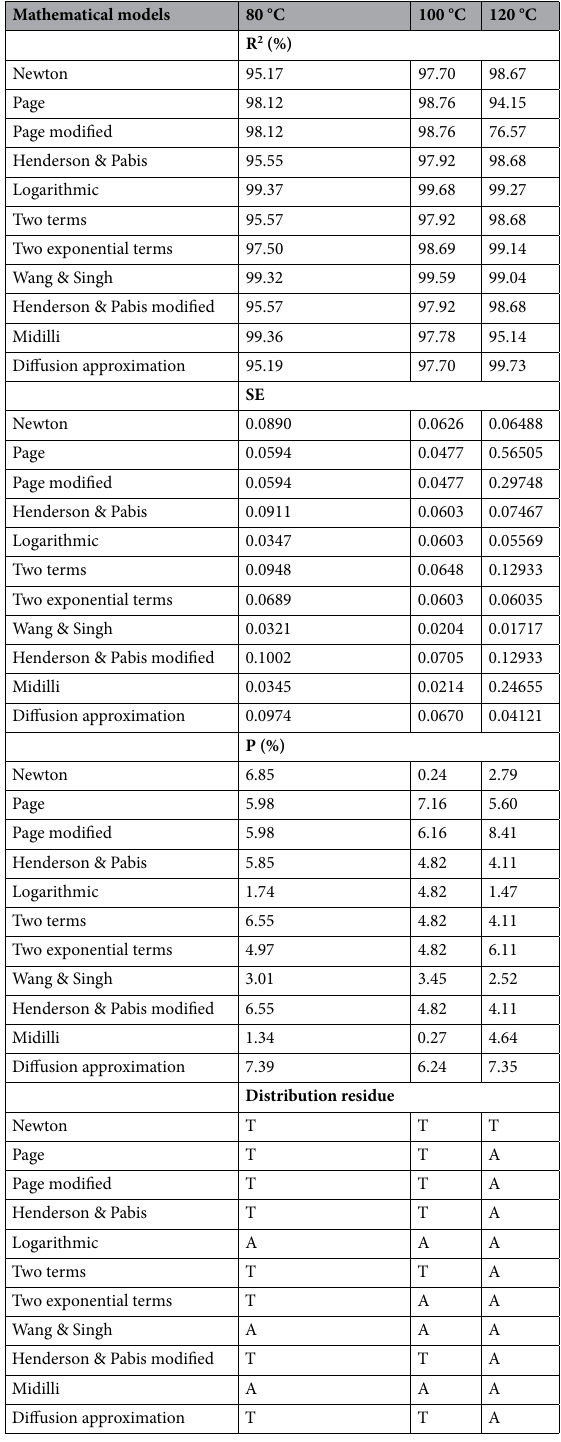
Table 2. Coefficient of determination (R 2 ), mean relative error (P), estimated values of average error (SE) drying of soybean grains due to different temperatures for 23% (d.b.) of initial moisture